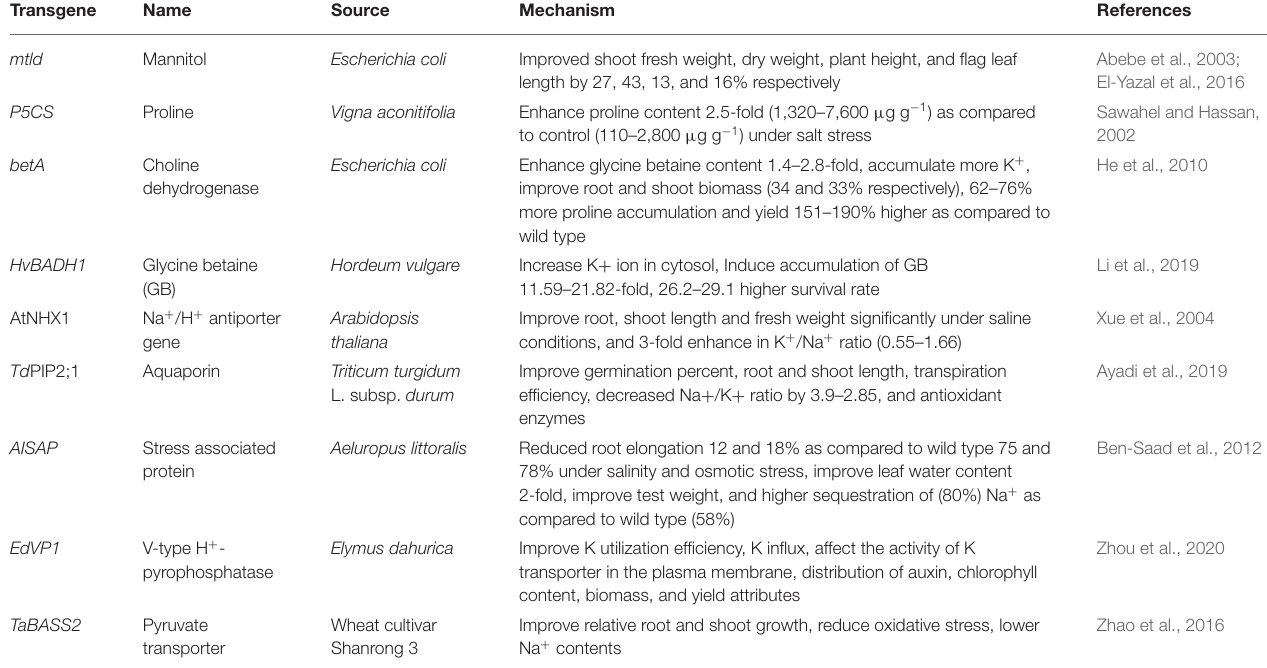
TABLE 1 | Highlights the some transgenic developed in wheat crop and influenced traits for salinity tolerance.